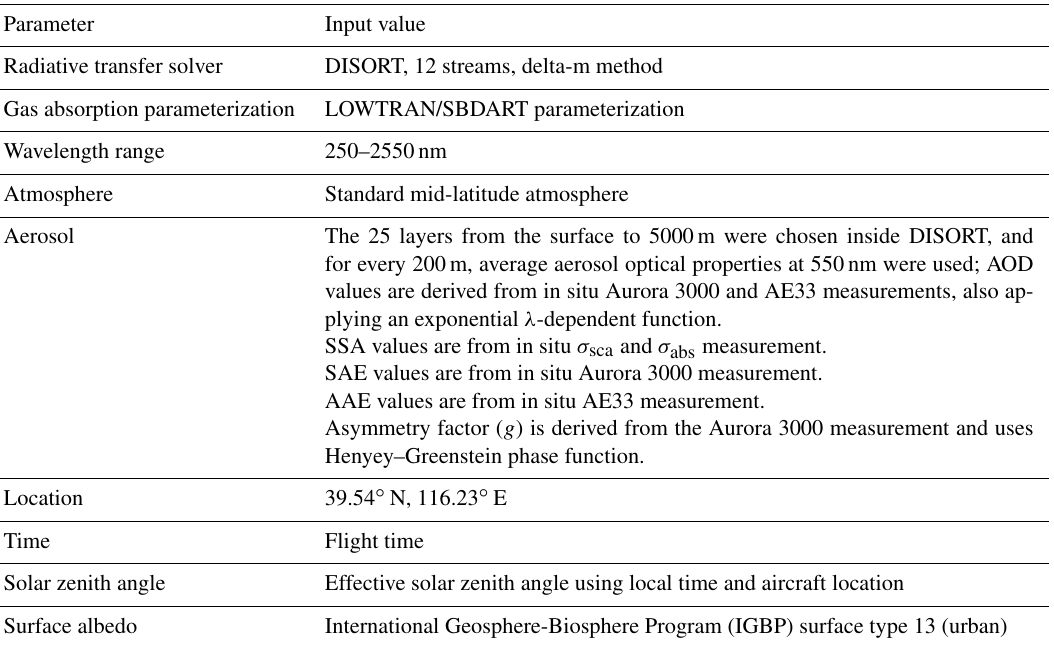
Table 2. Summary of input parameters for the radiative transfer calculation using discrete-ordinate radiative transfer code